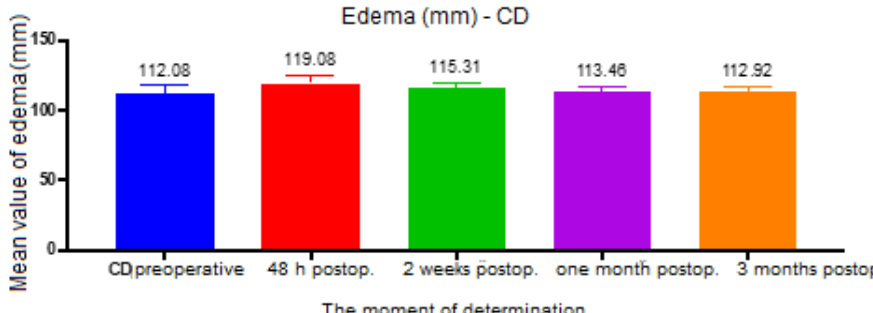
Figure 5. Edema assessment, CD distance.